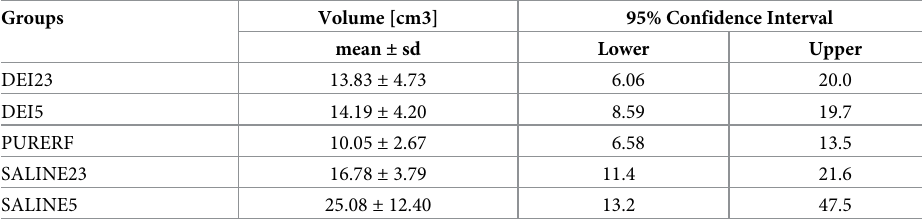
Table 1. Summary of volumes obtained by each experimental group.